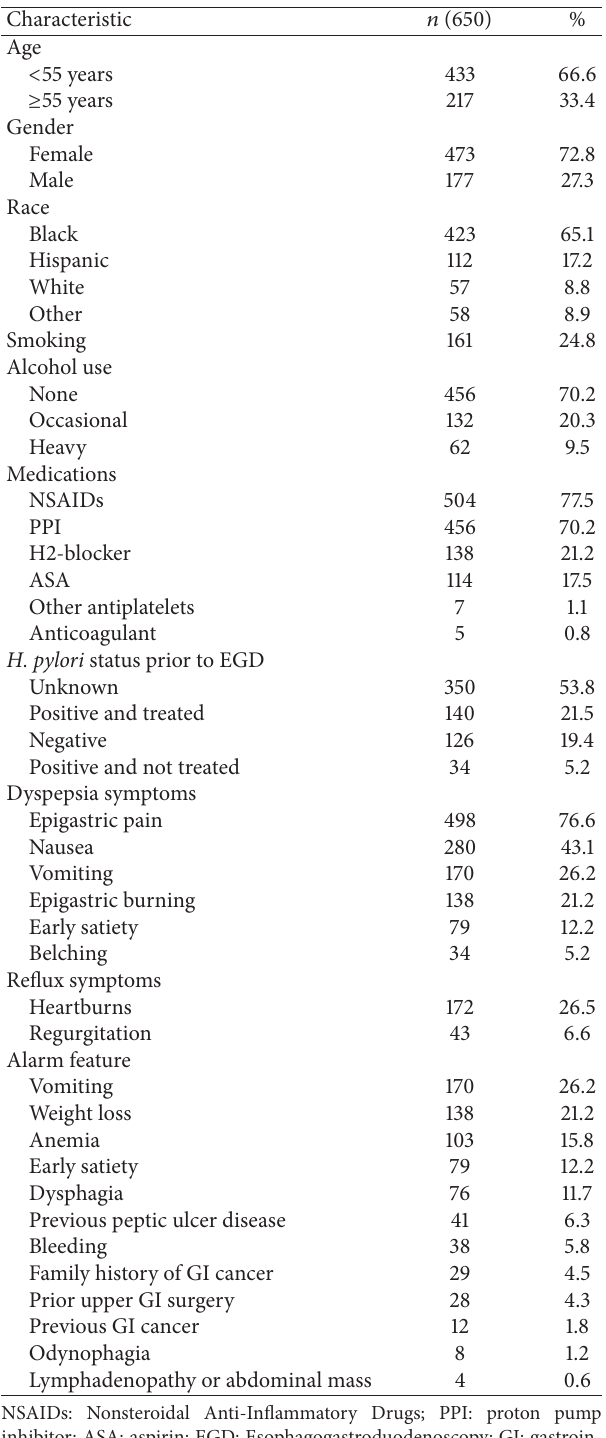
Table 1: Basics characteristics of outpatients with dyspepsia; Grady Memorial Hospital, Atlanta, Georgia, June 1, 2011–July 1,